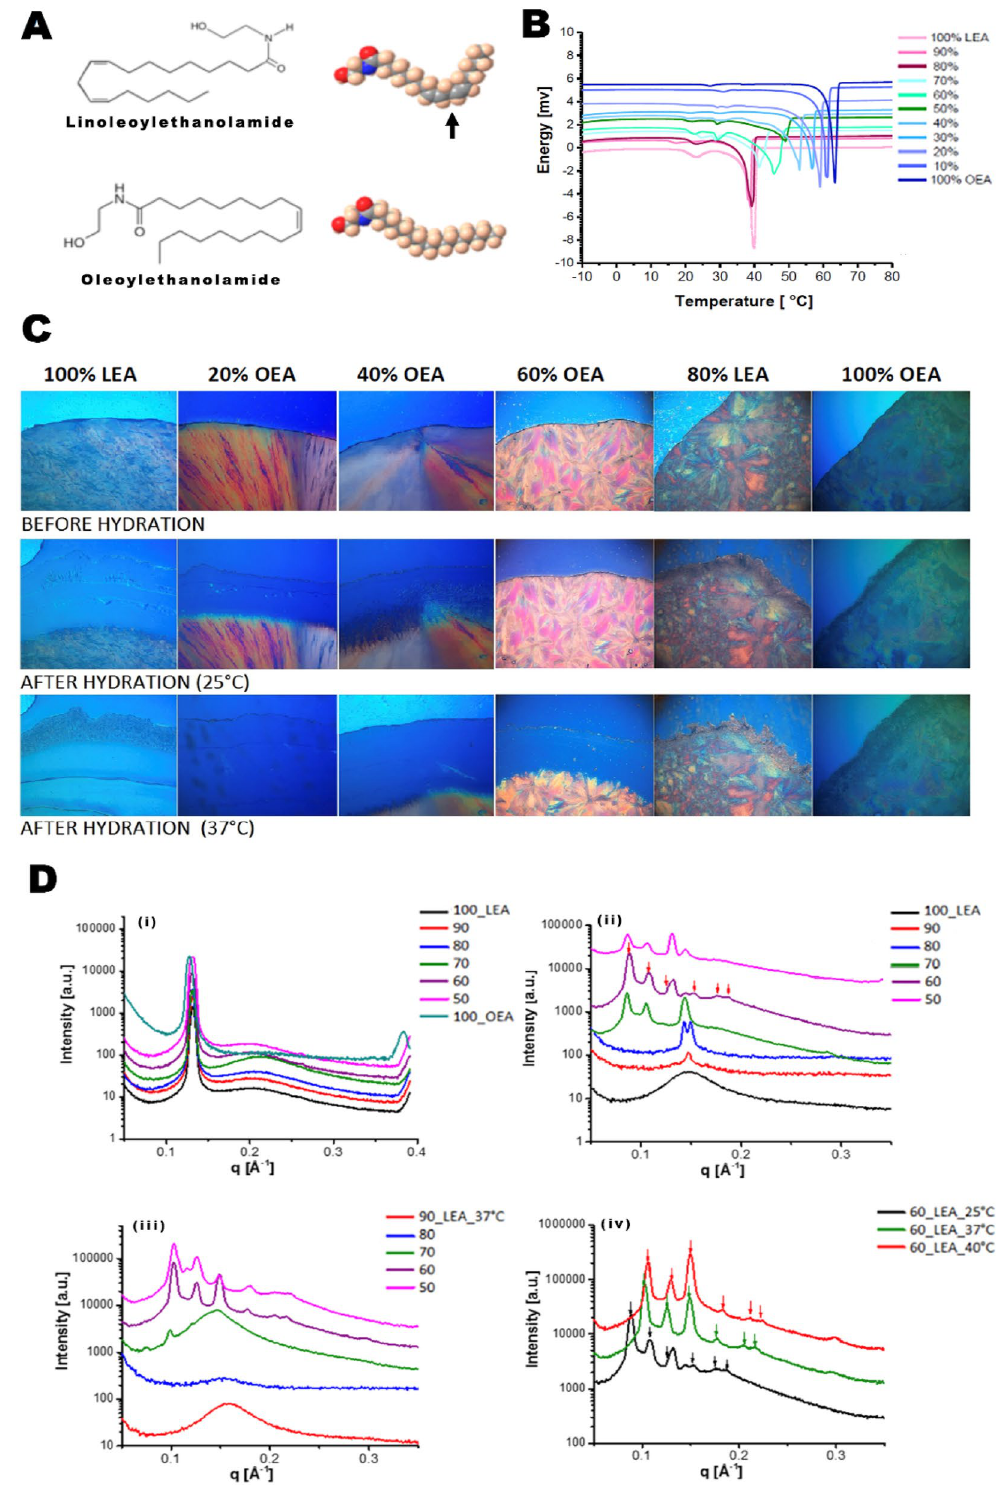
Figure 1. ( A ) Chemical structure and space filling molecular model of endocannabinoid lipids OEA and LEA. ( B ) Differential scanning calorimetry showing the melting behaviour of amphiphile mixtures composed of LEA and OEA, representing one single melting point of each mixture. ( C ) Optical microscopy of pure monoethanolamide lipids LEA and OEA; amphiphile mixtures at varying LEA to OEA ratios. Images acquired at 25 °C and 37 °C before and after hydration from a fixed position (magnification × 100). Different mesophases are observed from pure water to pure amphiphile. Polymorphic changes in the mesophases from cubic to a more lamellar phases were observed as the OEA to LEA ratio increased. ( D ) SAXS profiles of; (i) bulk and; (ii–iv) lyotropic mesophases of mixed LEA/OEA in excess water (70 wt%). The lyotropic mesophases were equilibrated for 48 h and analysed at 25 °C (ii) and 37 °C (iii). Lyotropic mesophases of 60% LEA at various temperatures (iv), show a cubic mesophase with Pn3m space group. The scattering vector q = (4π/λ) sin(θ/2), where λ is the X-ray wavelength and θ is the scattering